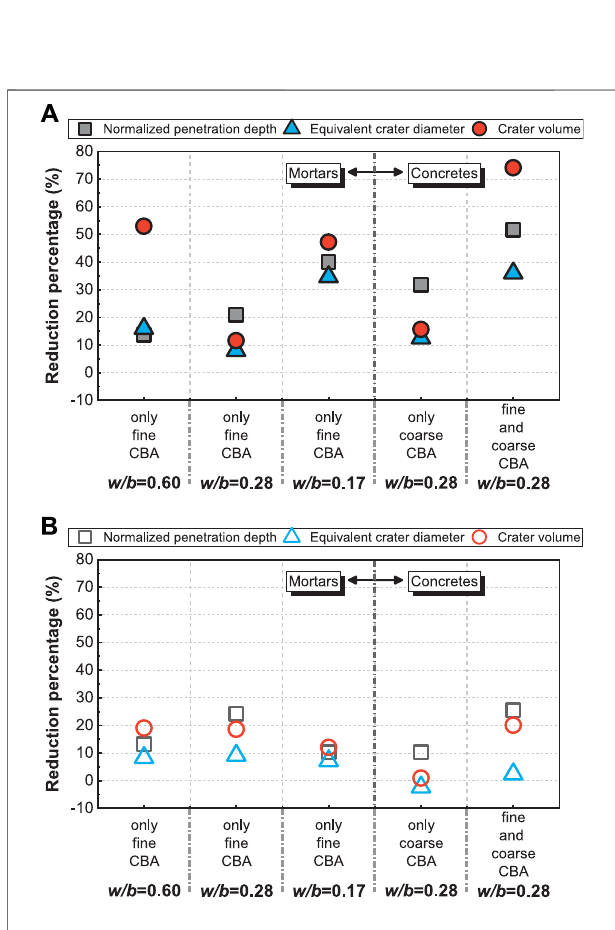
FIGURE 14 | Ef fi ciency of CBA in controlling the damage in cement composites subjected to HVPI using (A) copper and (B) steel